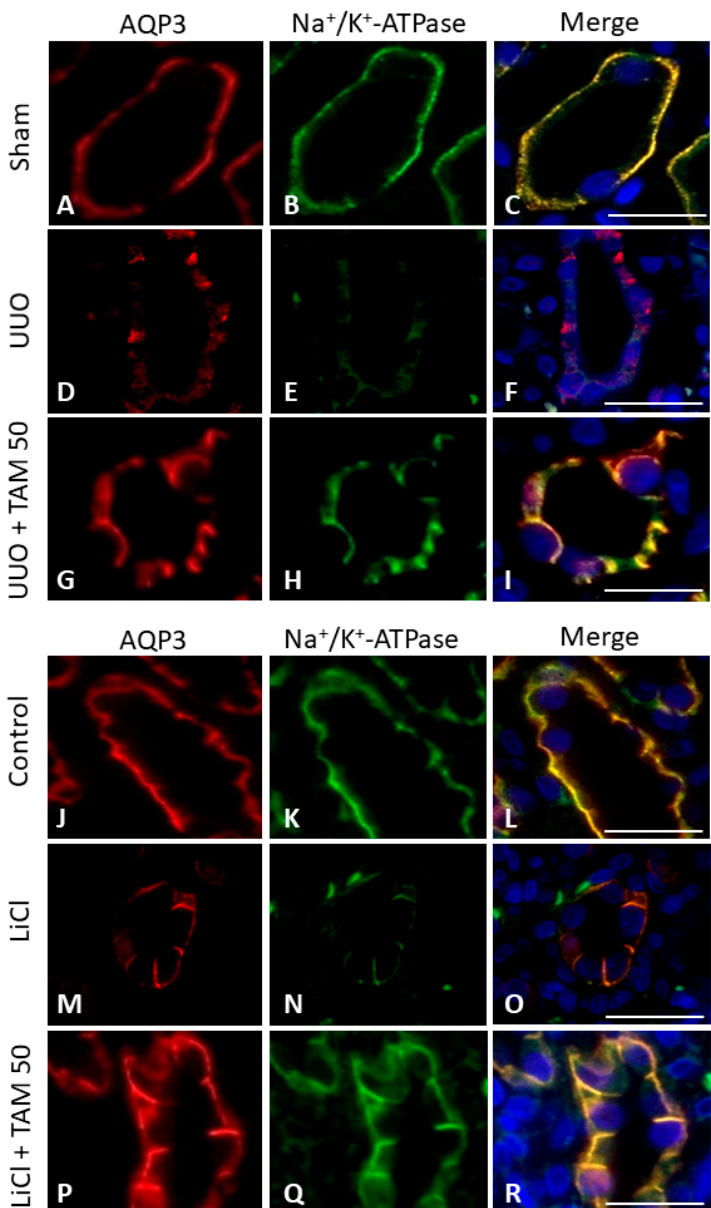
Figure 3. TAM affects expression and localization of AQP3 and Na/K-ATPase in rats subjected to UUO and LiCl treatment. ( A – I ): Representative immunofluorescence images of AQP3 (red) and Na/K-ATPase (green) expression in collecting ducts in ( A – C ) sham rats, ( D – F ) UUO rats, and ( G – I ) UUO rats treated with TAM 50 mg/kg (n = 3–4 per group). ( J – R ) Representative immunofluorescence images of AQP3 (red) and Na/K-ATPase (green) expression in collecting ducts in ( J – L ) control rats, ( M – O ) LiCl-treated rats, and ( P - R ) LiCl-treated rats treated with TAM 50 mg/kg (n = 4 per group). The yellow color represents co-localization between AQP3 and Na/K-ATPase. Scale bar 20 µm.